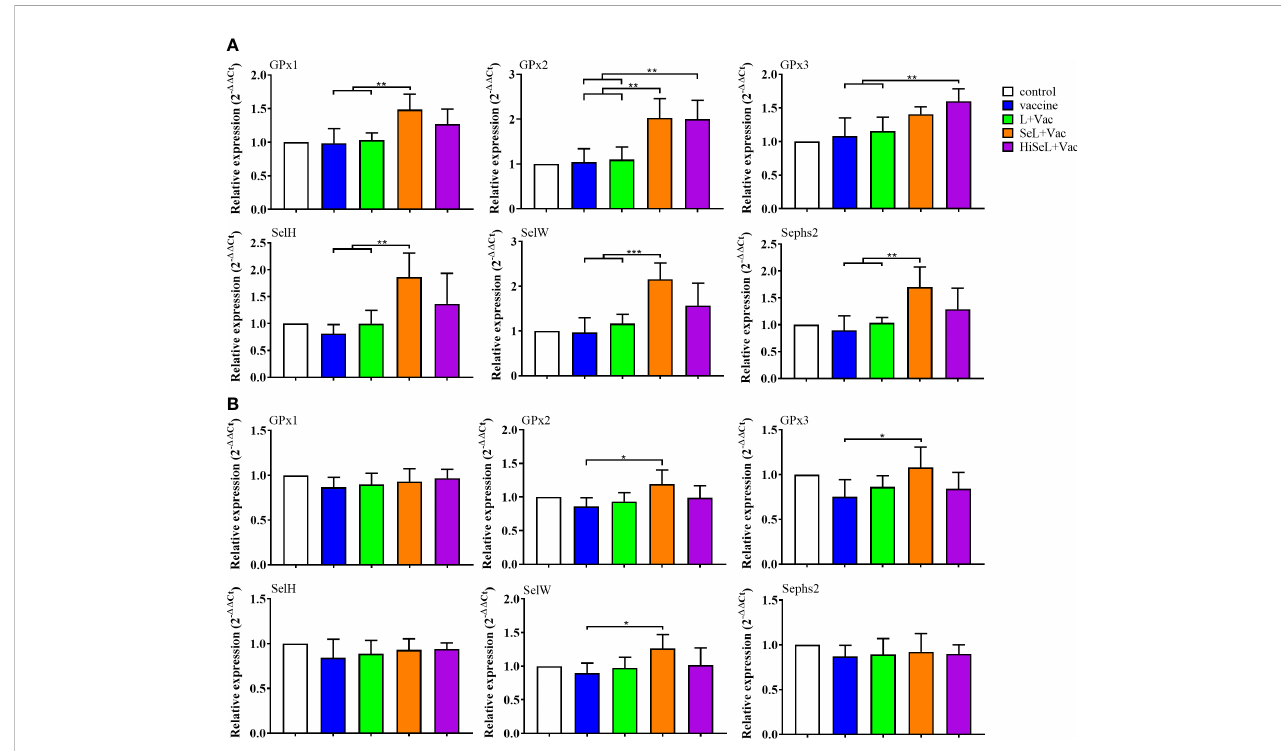
FIGURE 5 Effect of SeL and HiSeL on the mRNA levels of selenoprotein-related functional genes induced by the immunization of mice. Spleen samples of mice were gathered on days 1 and 28 after immunization to detect selenoprotein-related functional genes. (A) Results of mRNA level of selenoprotein-related functional genes in spleen on the fi rst day after immunization. (B) Results of mRNA level of selenoprotein-related functional genes in spleen on the 28th day after immunization. Each experimental group consisted of fi ve mice per group. Data were presented as means ± SD ( *P < 0.05, **P < 0.01, and ***P < 0.001). The statistical analysis was performed using one-way